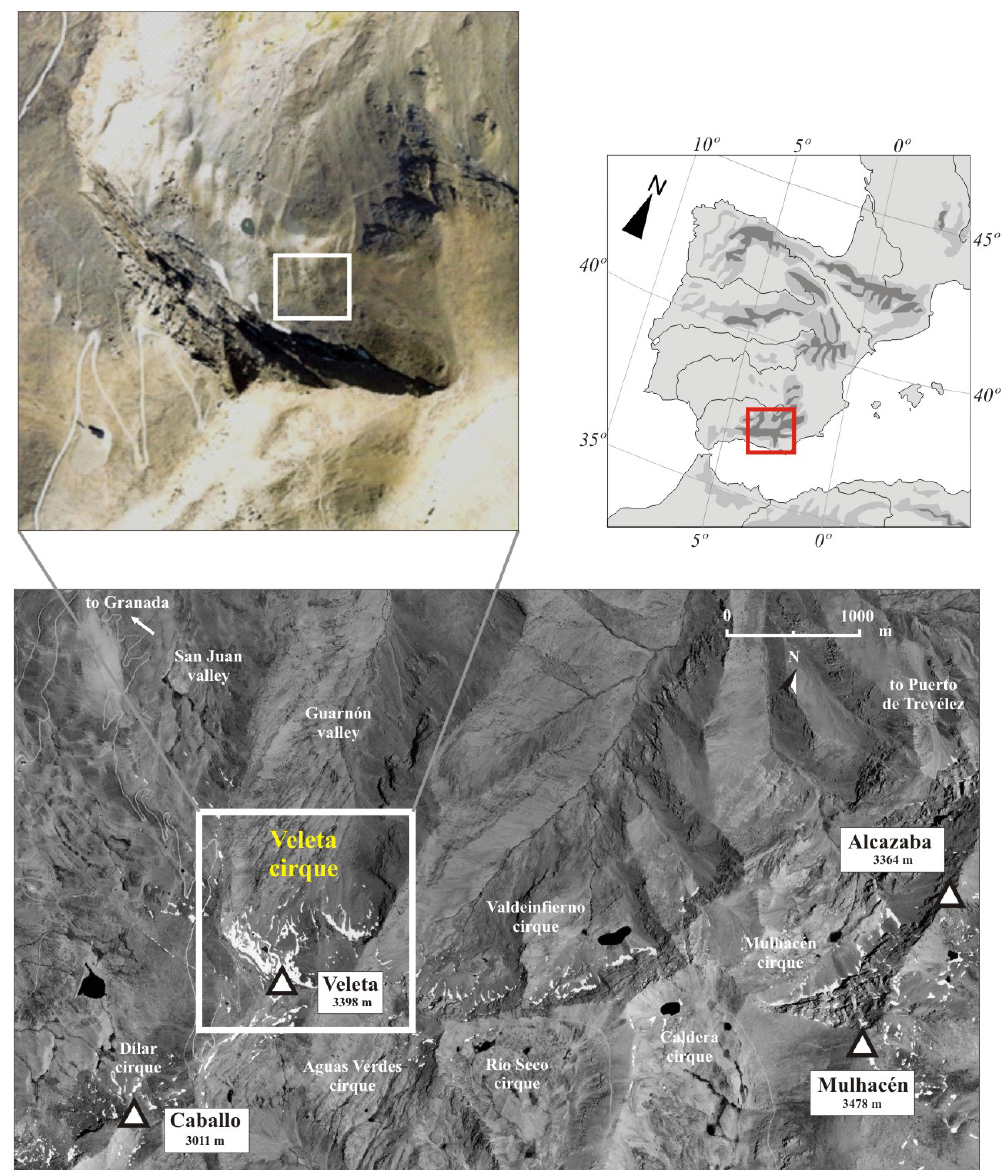
Figure 1. Sierra Nevada peaks and location of the Corral del